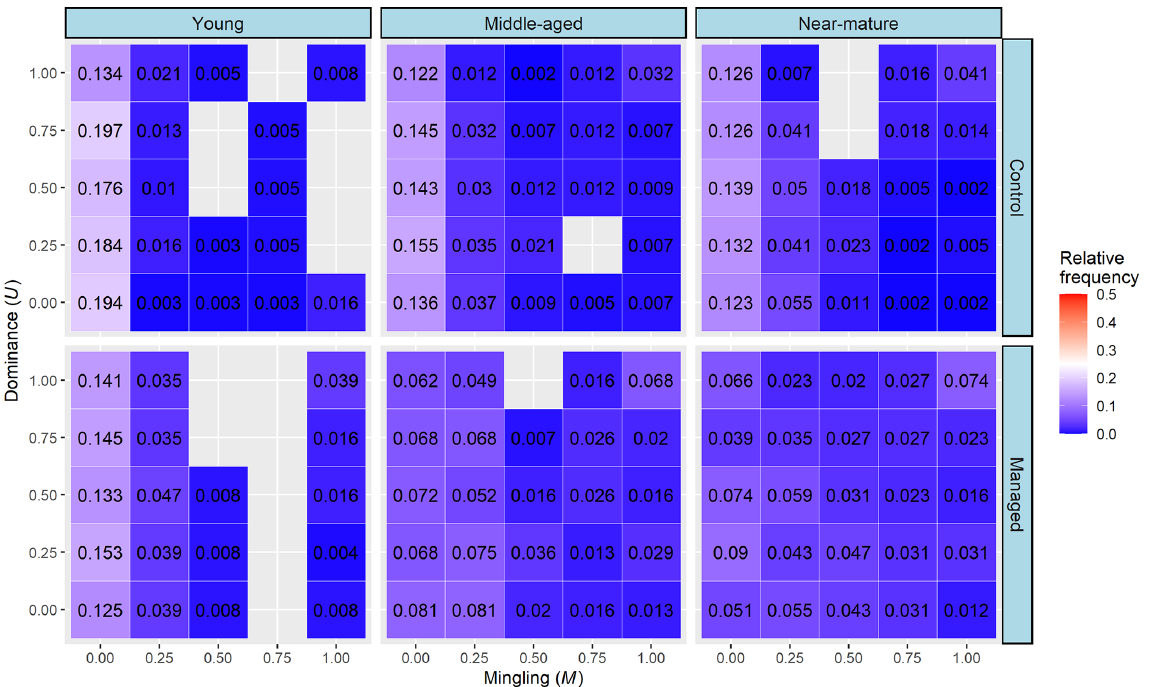
Figure 3. Bivariate distribution of M and U at different tree